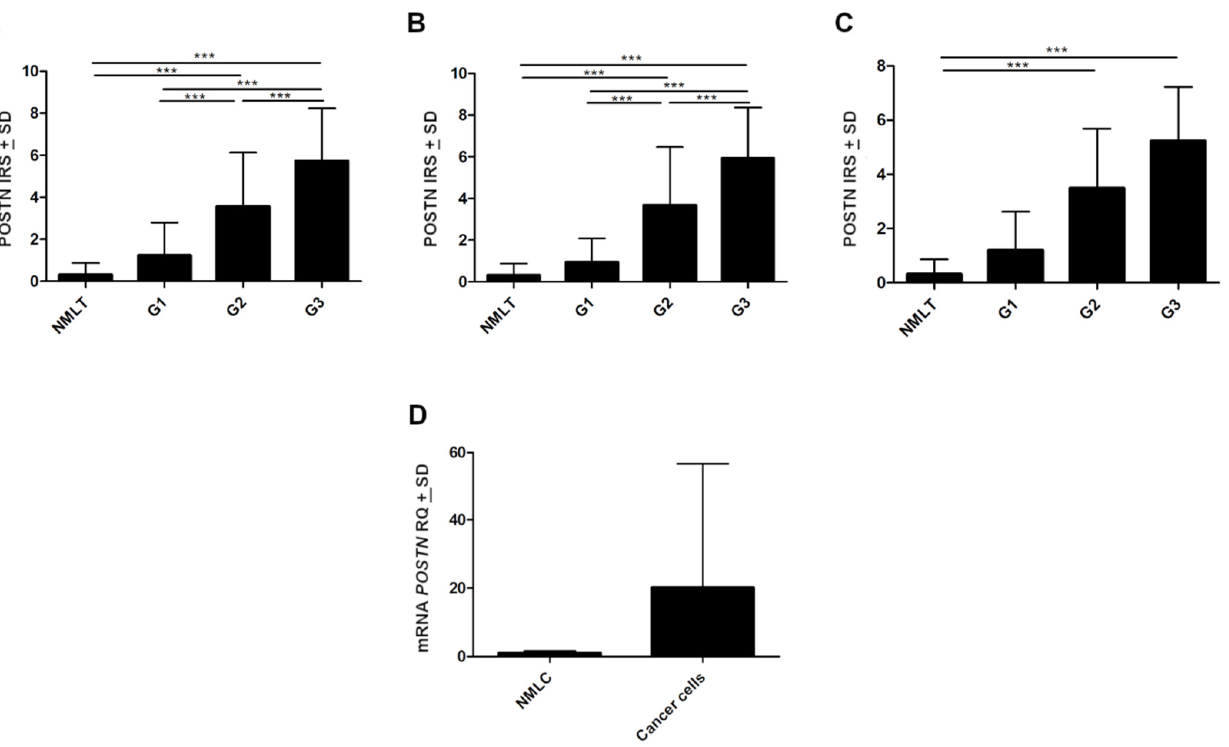
Figure 2. Immunohistochemical evaluation of periostin (POSTN) expression level according to the grade of malignancy (G) in ( A ) non-small cell lung carcinoma (NSCLC), ( B ) adenocarcinoma (AC), and ( C ) squamous cell carcinoma (SCC) compared to non-malignant lung tissue (NMLT), (*** p < 0.001). ( D ) The expression level of mRNA POSTN in microdissected (LCM) cancer cells compared to their expression in non-malignant lung cells (NMLC). IRS, immunoreactive score; RQ, relative quantification.